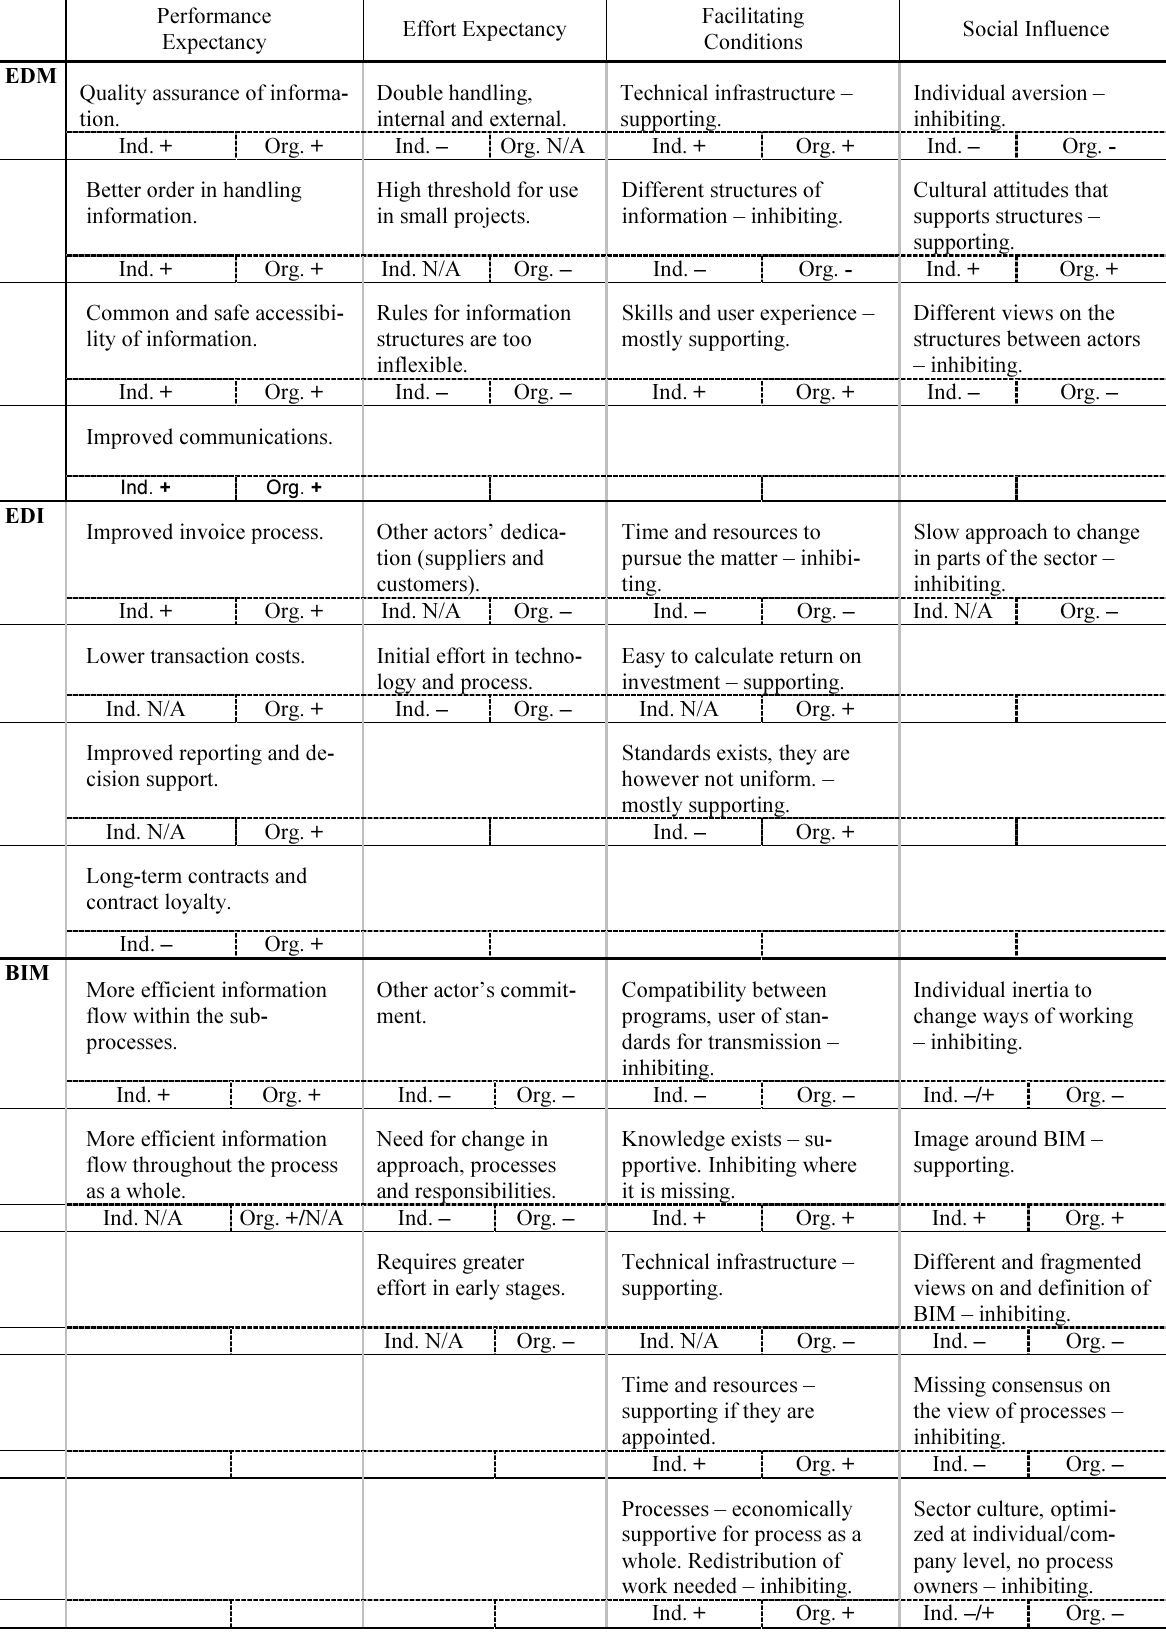
Table 3. The impact of different variables on the adoption and implementation of EDM, EDI and